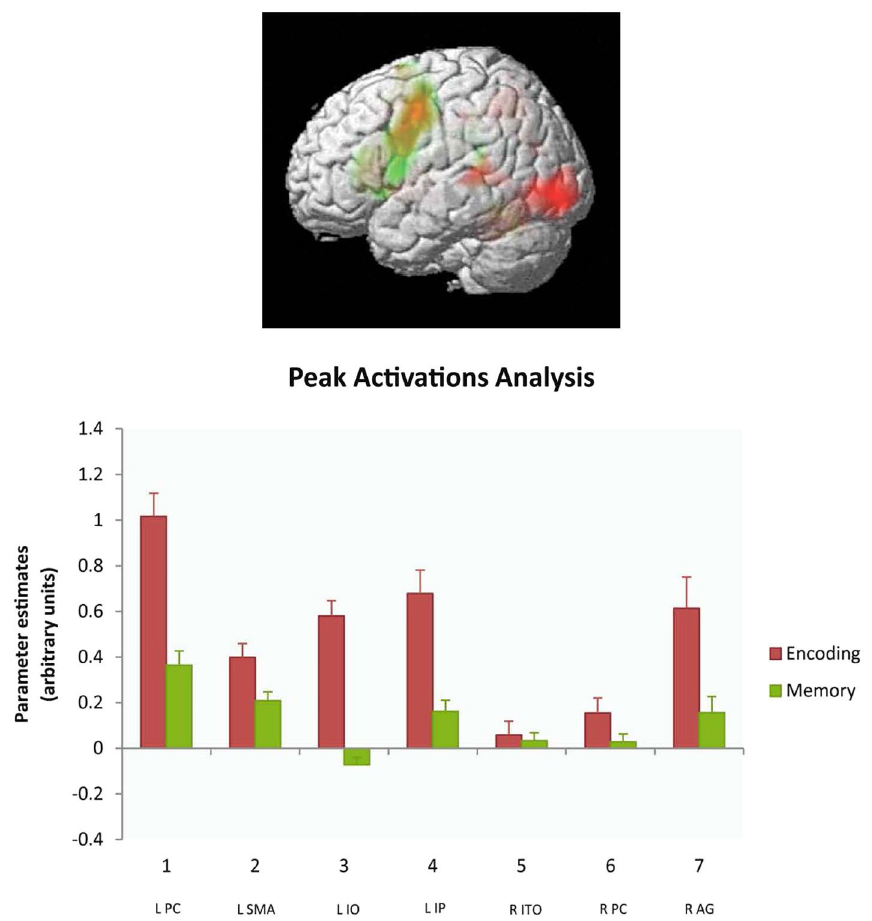
Figure 3. Memory load effects during the encoding interval (in red) contrasted with that during memory maintenance (in green; FDR p < 0.05). Note the pronounced overlapping activation in left dorsolateral premotor/ prefrontal cortex and in the supplementary motor area. L PC, left precentral/prefrontal cortex; L SMA, left supplementary motor area; L IO, left inferior occipital cortex; L IP, left inferior parietal cortex; R ITO, right inferior temporal-occipital cortex; R PC, right precentral gyrus; R AG, right angular